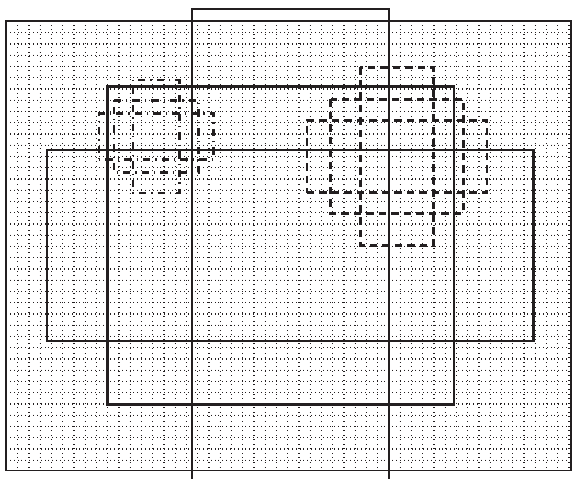
Figure 2: Illustration of RPN network.